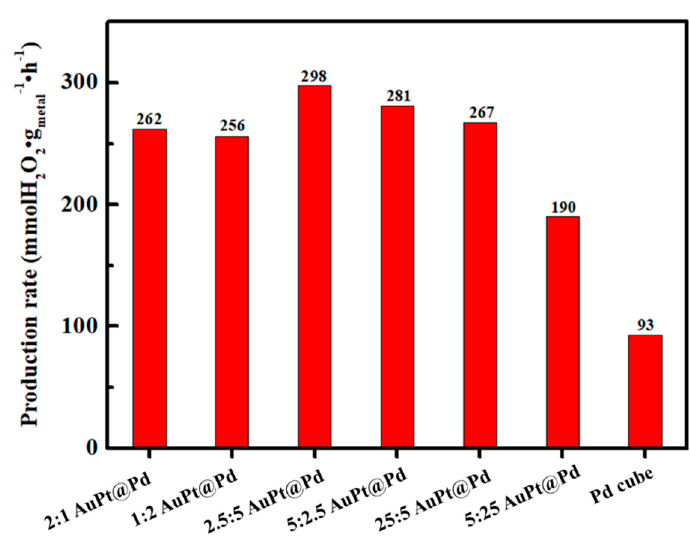
Figure 5. Production rates of AuPt@Pd core–shell nanoparticles with varying Au and Pt mol%, in relation to Pd, in the fast-screening test for the direct synthesis of H 2 O 2 .